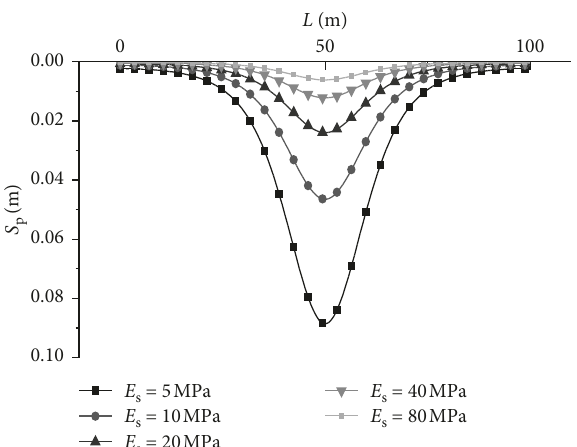
Figure 3: Transverse subsidence of pipeline in different soil compression